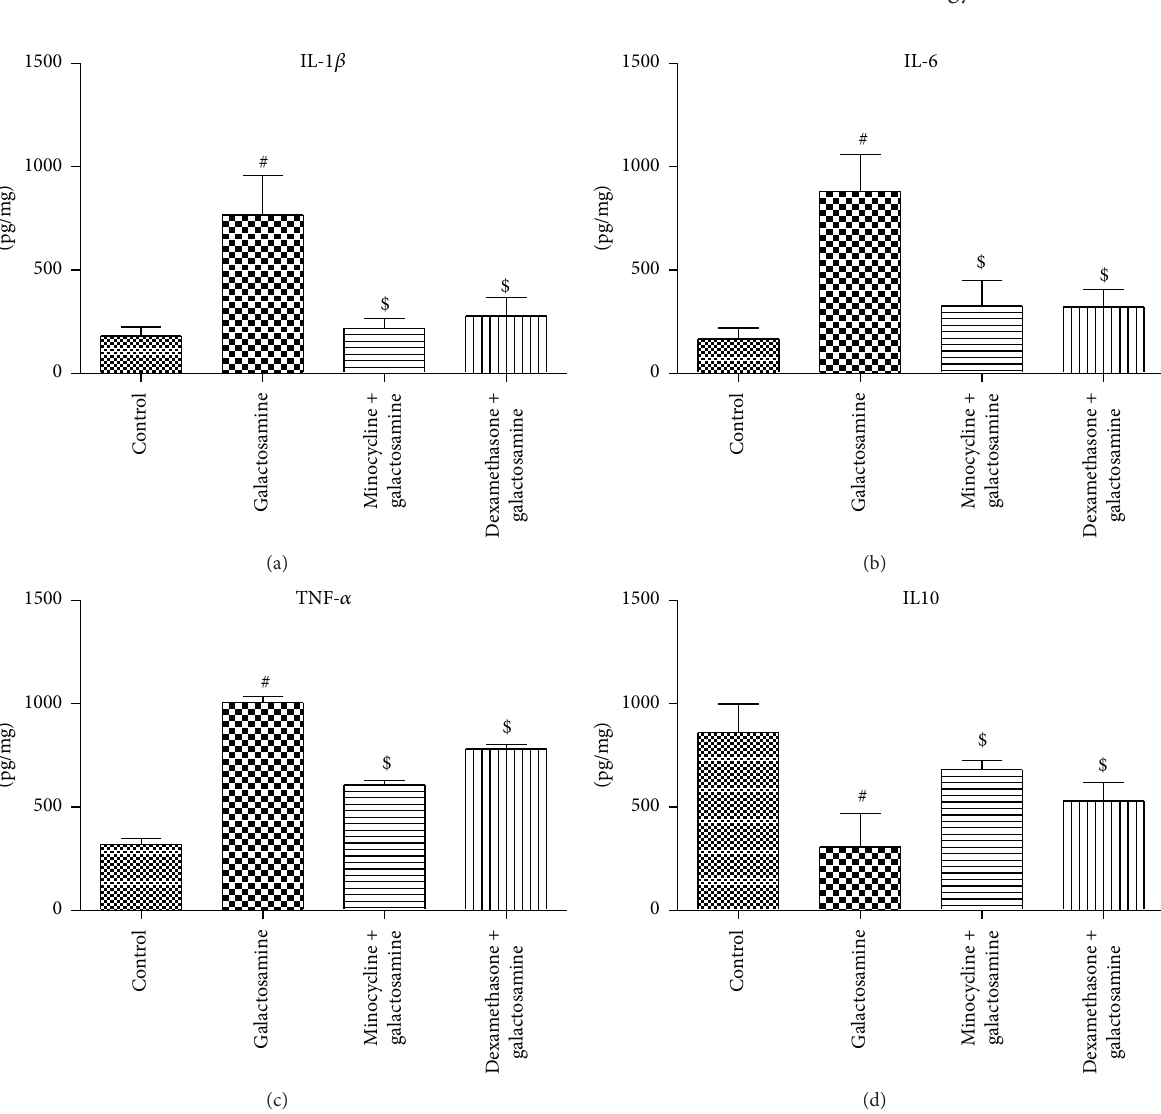
Figure 2: The effects of minocycline and dexamethasone on the inflammatory changes associated with minimal hepatic encephalopathy. Both dexamethasone and minocycline ( 𝑛 = 6 per group) reduced the levels of IL-1 𝛽 (pg/mg) (a), IL-6 (pg/mg) (b), and TNF- 𝛼 (pg/mg) (c) and increased the level of IL-10 (pg/mg) (d) in the brain tissue associated with acute liver injury. All values are expressed in means ± SD. # 𝑃 < 0.05 versus control; $ 𝑃 < 0.05 versus galactosamine treated